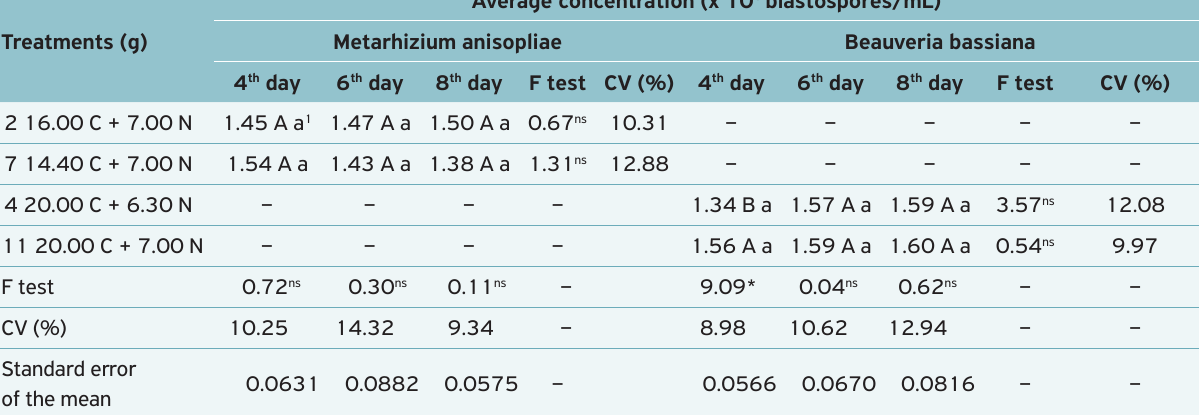
Table 4. Average concentration of Metarhizium anisopliae (IBCB 425) and Beauveria bassiana (IBCB 66), obtained from the liquid culture media in different concentrations of nitrogen and carbon, at four, six and eight days after inoculation (at 26 ± 1°C and 12-hour